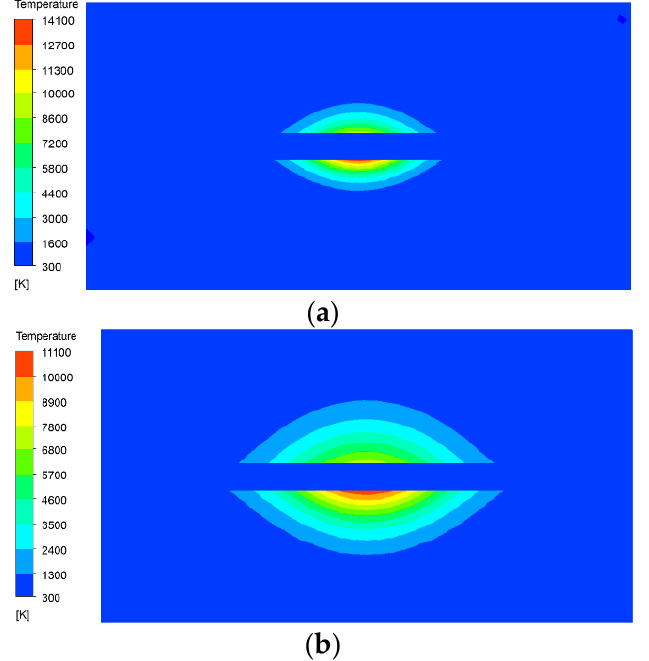
Figure 8. Temperature field distribution on the tool and workpiece at different discharge moments. ( a ) Discharge time at 5 μs; ( b ) Discharge time at 20 μs.